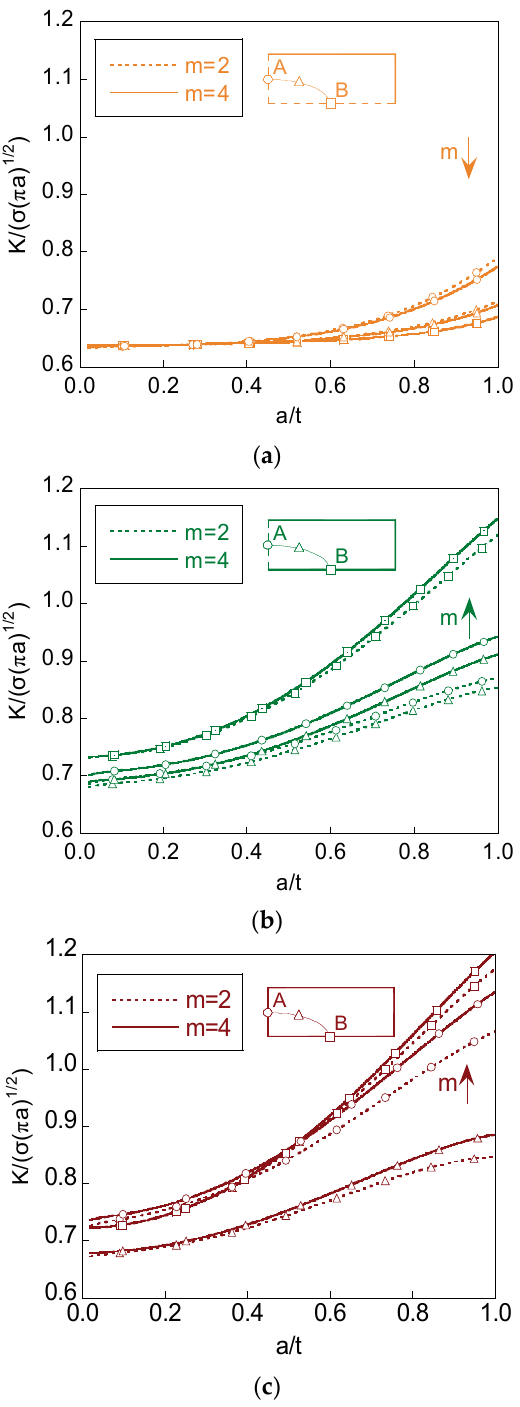
Figure 7. Dimensionless SIFs for the preferential cracking paths given at the A, B, and intermediate points located on the front of a crack of the following types: ( a ) embedded; ( b ) surface; ( c ) corner. (The arrows indicate the direction in which the curves are moved with the increase of the Paris m exponent).